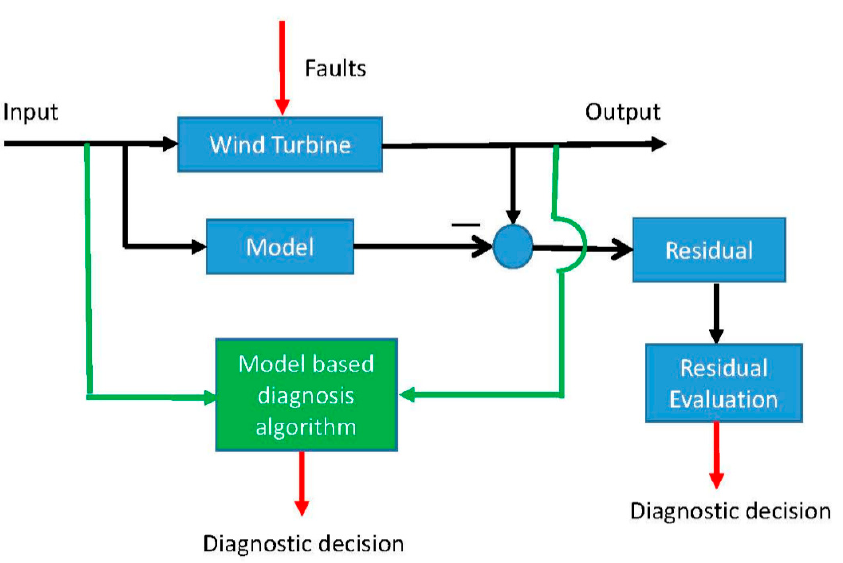
Figure 4. Schematic diagram of model-based fault diagnosis.